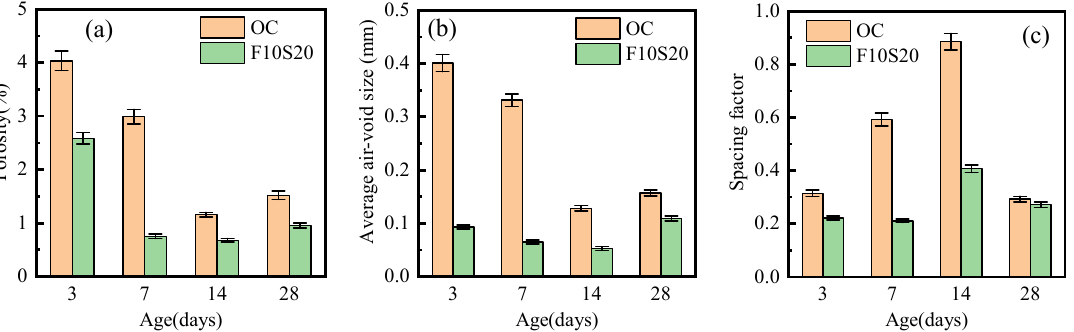
Figure 10. Concrete air ‐ void parameters with curing age: ( a ) Porosity; ( b ) Average air ‐ void size; ( c ) Spacing factor. The air ‐ void size distribution of OC and F10S20 concrete at different ages was drawn